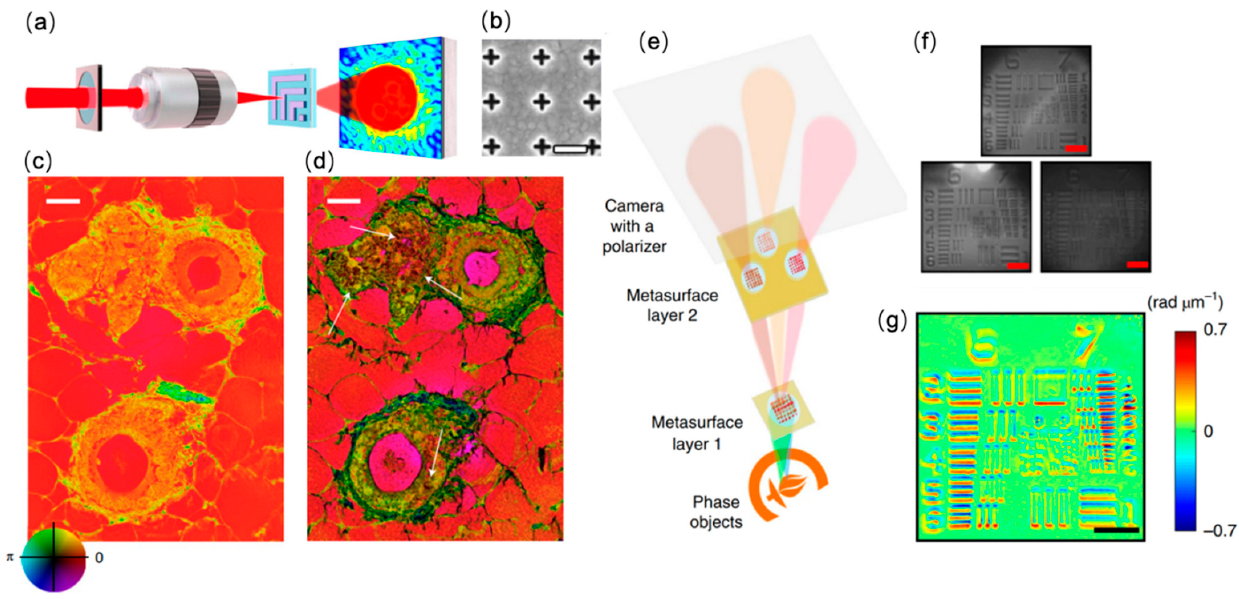
Figure 1. Metasurface-based phase contrast microscopy. ( a ) Schematic of the surface plasmon en- hanced ptychographic phase microscope. ( b ) SEM image of the nanostructured metasurface for surface plasmon generation. Sale bar: 450 nm. ( c ) Ptychographic reconstructed phase image of an un- stained tissue section. ( d ) Metasurface-enhanced ptychographic phase image of the same tissue sam- ple shown in ( c ). Scale bar: 25 μ m. Reprinted with permission from Ref. [54]. Copyright 2021 Springer Nature. ( e ) Schematic of the compact metasurface-based quantitative phase microscope. ( f ) Three differential interference contrast (DIC) images obtained by the metasurfaces. Scale bar: 50 μ m. ( g ) Reconstructed phase image of the target in ( f ). Scale bar: 50 μ m. Reprinted with permission from Ref. [55]. Copyright 2019 Springer Nature.